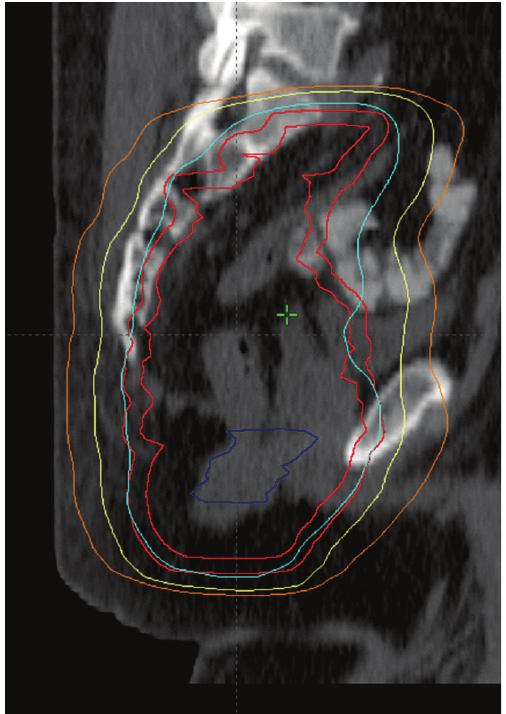
Figure 2: Sagittal images of an IMRT plan. This 56-year-old man was found to have an uT3N0 rectal adenocarcinoma and managed with preoperative CRT consisting of capecitabine with a seven-field coplanar IMRT plan to a total dose of 4500 cGy followed by a boost to the GTV to a total of 5040 cGy. The 95%, 70%, and 50% isodose curves are displayed along with the